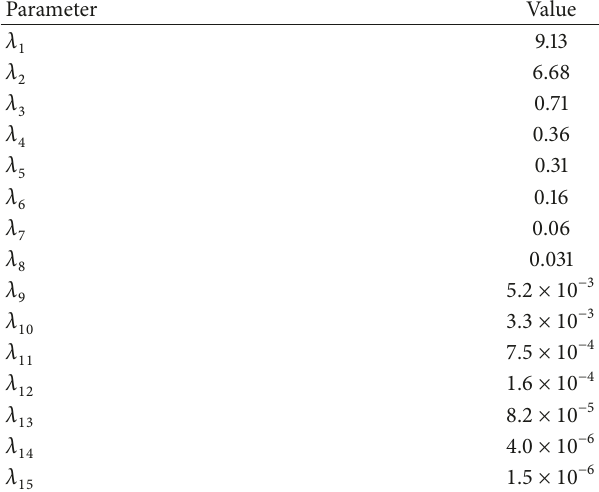
Table 2: Eigenvalues of covariance matrix.